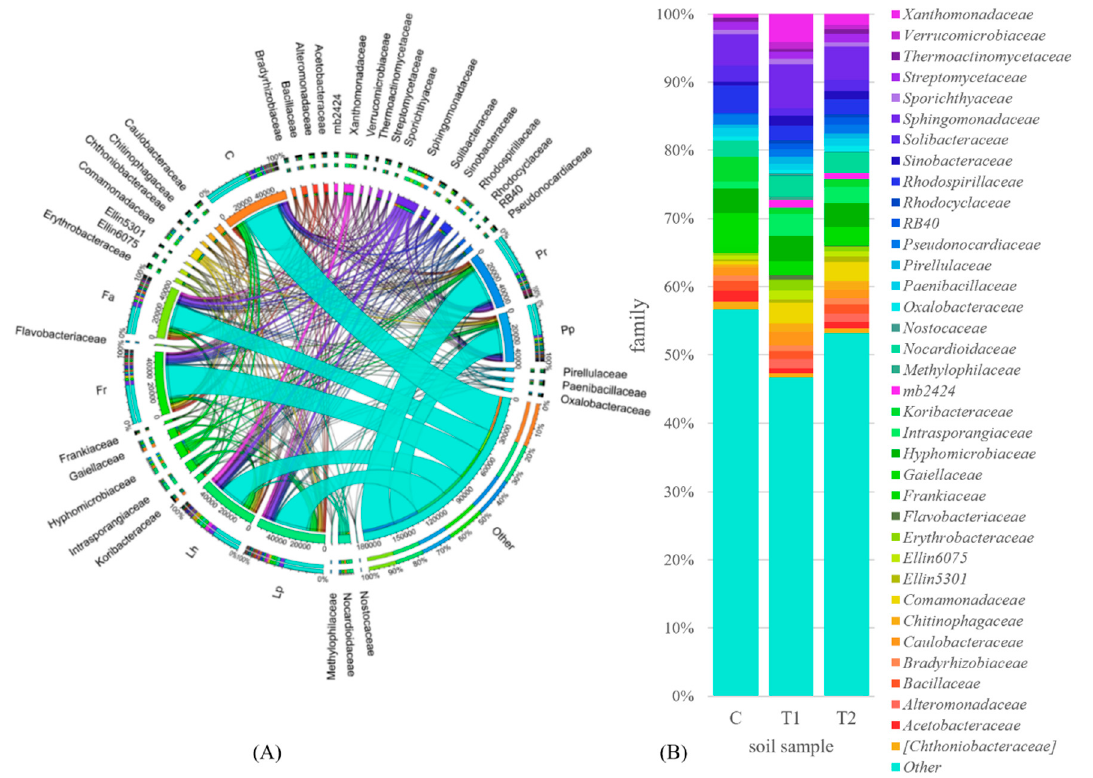
Figure 8. Bacterial communities at the family level ( A ) depending on the species of grass, ( B ) depending on grass type (fodder or lawn). Abundances < 1% are gathered into the category “other”. C—unsown soil; T1—average bacteria abundance in soils sown with fodder grasses; T2—average bacteria abundance in soils sown with lawn grasses. Lh— Lolium x hybridum Hausskn; Fa— Festuca arundinacea ; Pp— Phleum pratense , Lp— Lolium perenne , Pr— Poa pratensis ; Fr— Festuca rubra .